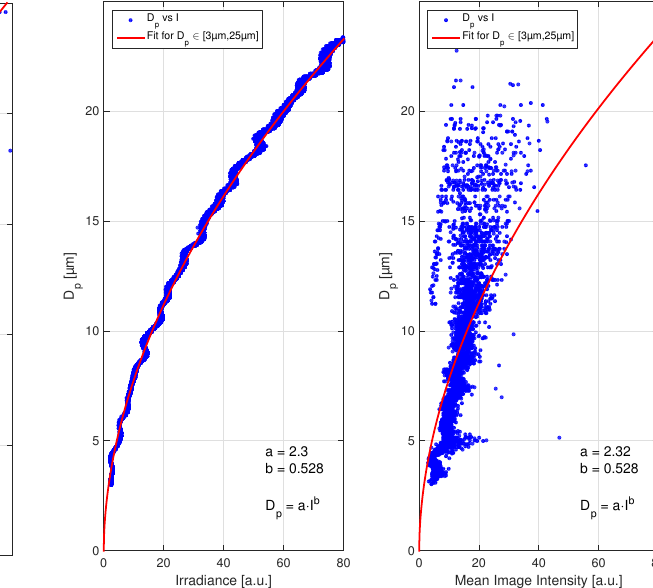
Figure 6. Size calibration of the SID-3 mean image intensity. Left panel: scattered irradiances in 7.0 to 23.5 ◦ forward direction calcu- lated by Lorenz–Mie theory for water droplets. Right panel: analy- sis result obtained from the measurement of a dense droplet cloud during RICE 01 at the AIDA